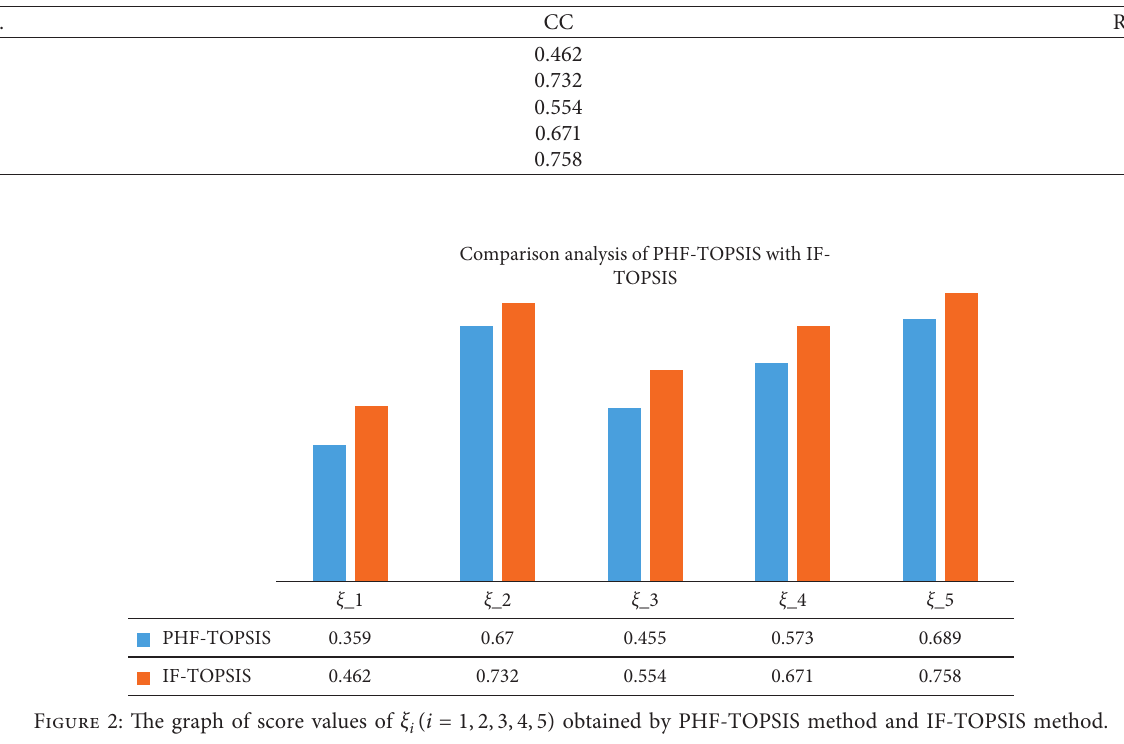
( i � 1 , 2 , 3 , 4 , 5 ) obtained by PHF-TOPSIS method and IF-TOPSIS i